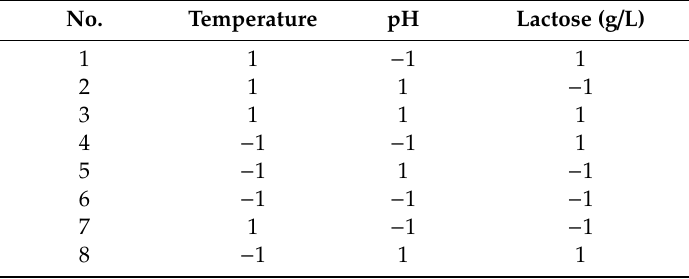
Table 2. The Plackett–Burman design for two levels of the three independent factors. No. Temperature pH Lactose (g /